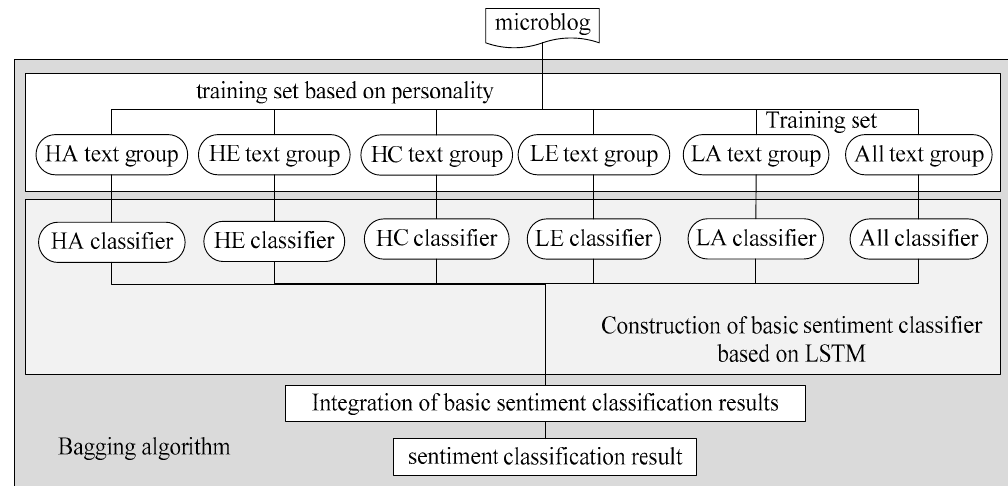
Figure 2. T he sentiment classification process based on personality and bagging algorithm. Figure 2. The sentiment classification process based on personality and bagging